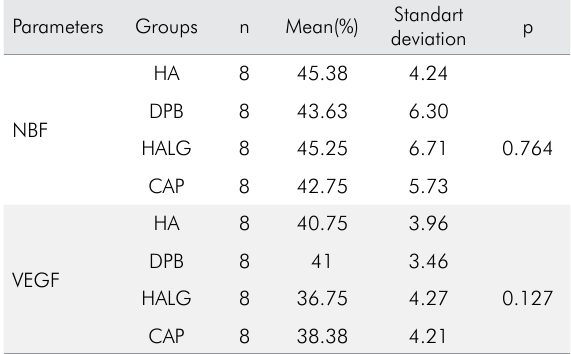
Table. New bone formation (NBF) and vascular endothelial growth factor (VEGF) percentage of the groups (one way ANOVA, p >